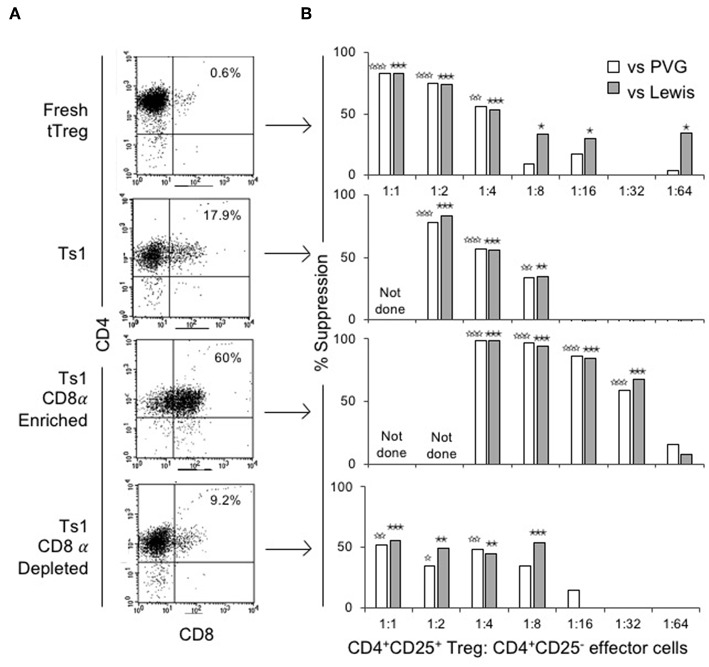
Phenotype and suppression capacity in vitro of CD8α expressing population of CD4+CD25+T cells post-culture with rIL-2 and alloantigen. (A) FACS analysis of fresh naïve tTreg pre-culture and post-culture unfractionated Ts1 cells, and CD8α-enriched and CD8α-depleted Ts1 cells. Unfractionated Ts1 had ~18% cells that expressed CD8α, CD8α-enriched cells were 60% CD4+CD8α+ and CD8α-depleted were only 9% CD4+CD8α+. (B) tTreg, unfractionated Ts1, CD8α-enriched Ts1 and CD8α-depleted Ts1 cells were examined for suppression capacity against CD4+CD25−T cells from naïve DA rats stimulated in MLC with either specific donor PVG or third-party Lewis alloantigens. A 3H thymidine incorporation assay was used to detect proliferation, and cultures were harvested at day 5. Data expressed as percent suppression as: % suppression= Teff prolif with Ag - Teff prolif with Ag and TregTeff prolif with AgX 100. All groups had 4–6 replicates. tTreg suppressed up to a ratio of 1:4 while unfractionated Ts1 could suppress up to 1:8 of Treg to T effector cells ratio. CD8α-enriched Ts1 suppressed at 1:32 ratio and CD8α-depleted Ts1 only suppressed up to 1:8 ratio similar to unfractionated Ts1 cells. Significant differences are shown as ☆ (comparison to effector cells proliferation with PVG) or ★ (comparison to effector cells proliferation with Lewis), ☆, ★p ≤ 0.05, ☆☆, ★★p ≤ 0.01, and ☆☆☆, ★★★p ≤ 0.001.